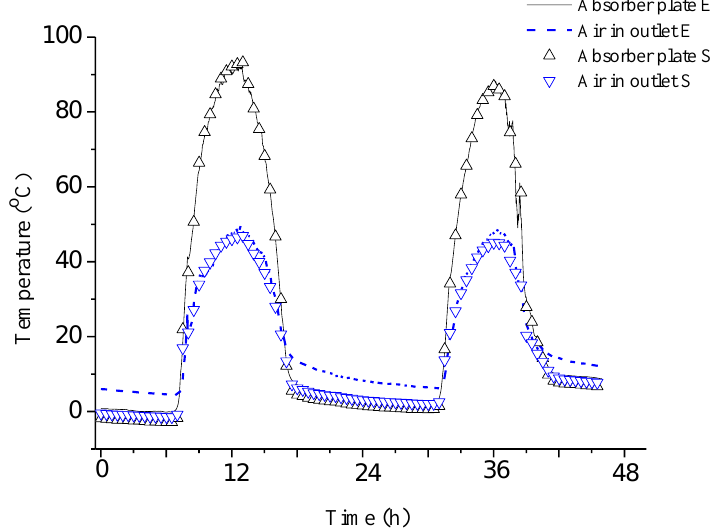
Figure 6. Comparison of measured and predicted temperatures of absorber plate and outlet of DFSC (E—experiment; S—simulation).